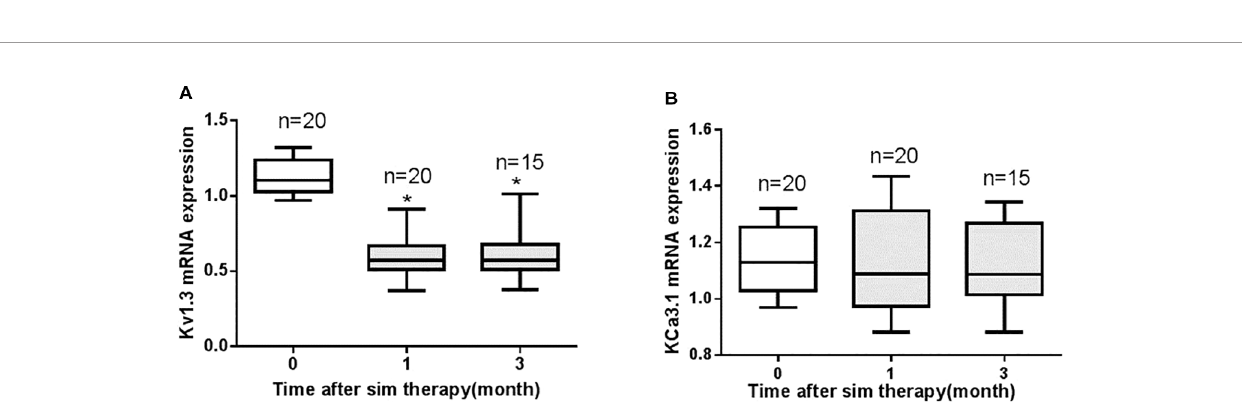
FIGURE 7 | The mRNA expression of Kv1.3 and KCa3.1 in peripheral blood mononuclear cells (PBMCs) collected from healthy persons and patients with coronary atherosclerotic artery disease (CAD), respectively, determined by quantitative real-time PCR. The samples from healthy persons were used as controls. (A) The mRNA expression level of Kv1.3 in CAD patients (n = 20) was signi fi cantly higher than controls (n = 22), * P < 0.05. (B) The mRNA expression level of KCa3.1 in CAD patients (n = 20) was signi fi cantly higher than controls (n = 22).